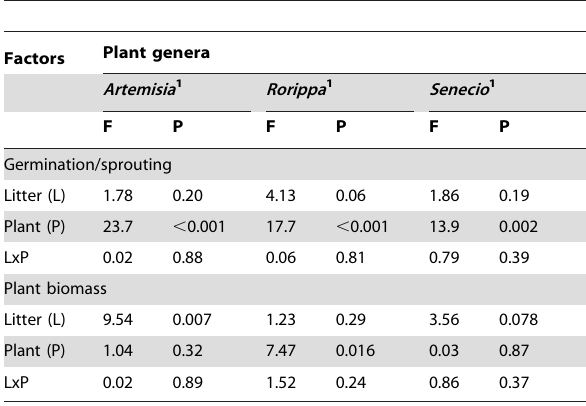
Table 3. ANOVA for effects of litter on soil properties. Factors